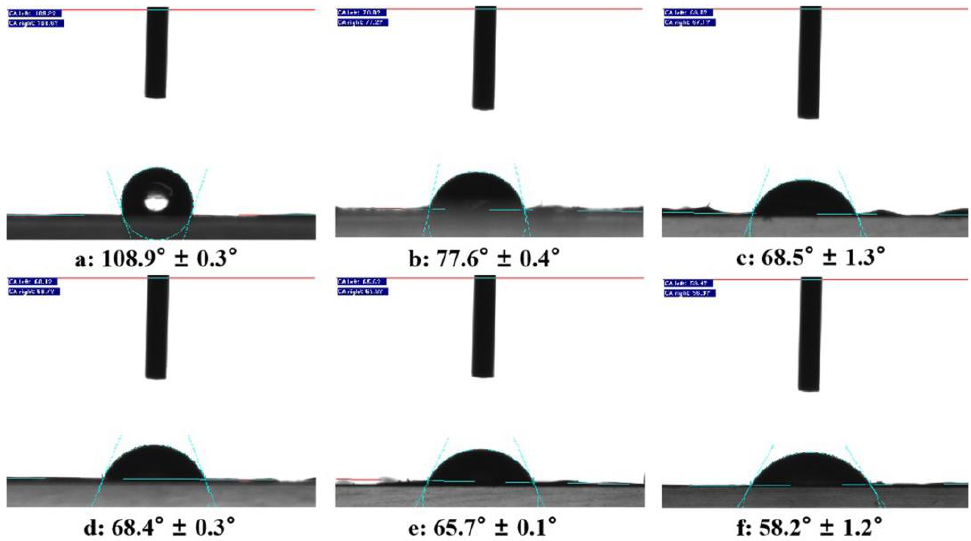
Figure 3. Static water contact angle of gelatin/genipin membranes with levofloxacin content in ( a ) 0 wt%, ( b ) 1 wt%, ( c ) 2 wt%, ( d ) 3 wt%, ( e ) 4 wt%, ( f ) 5 wt%.